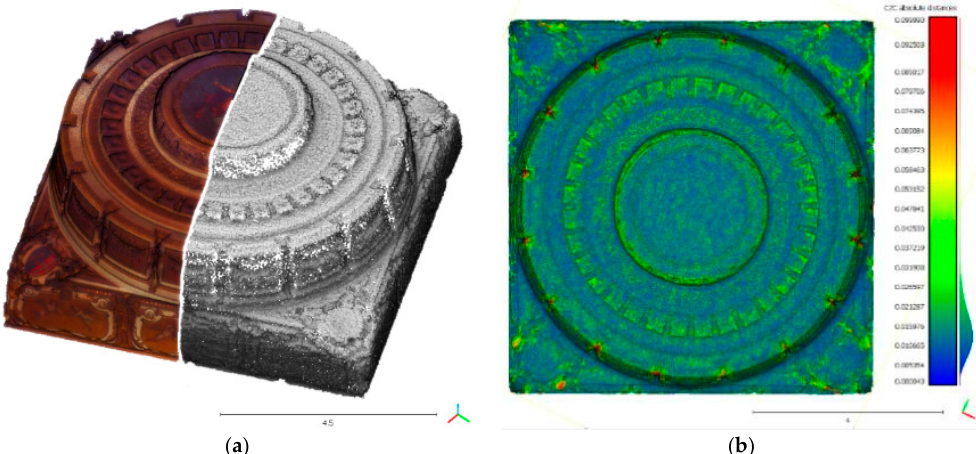
Figure 15. ( a ) The Roses Chamber vault and the ( b ) C2C distances analysis between LiDAR and ZEB. Table 7. Comparison of point density related to the close-range photogrammetric model, LiDAR scan, and ZEB scan of the Fleur-de-lis Chamber . Similarities between (*) and between ( # ). (a) Close-Range SfM